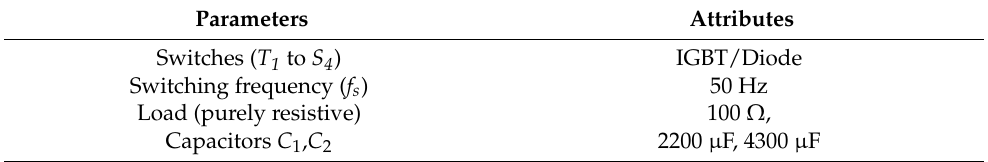
Table 3. Parameters used in the simulation of the symmetrical and asymmetrical